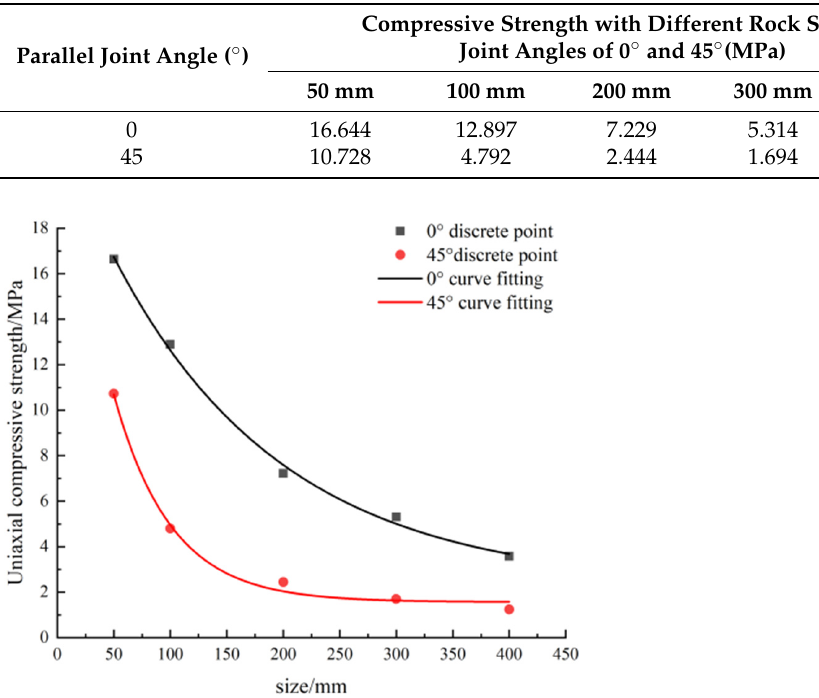
Figure 18. Fitting curve of UCS with differently sized rocks at parallel joint angles of 0° and 45°.